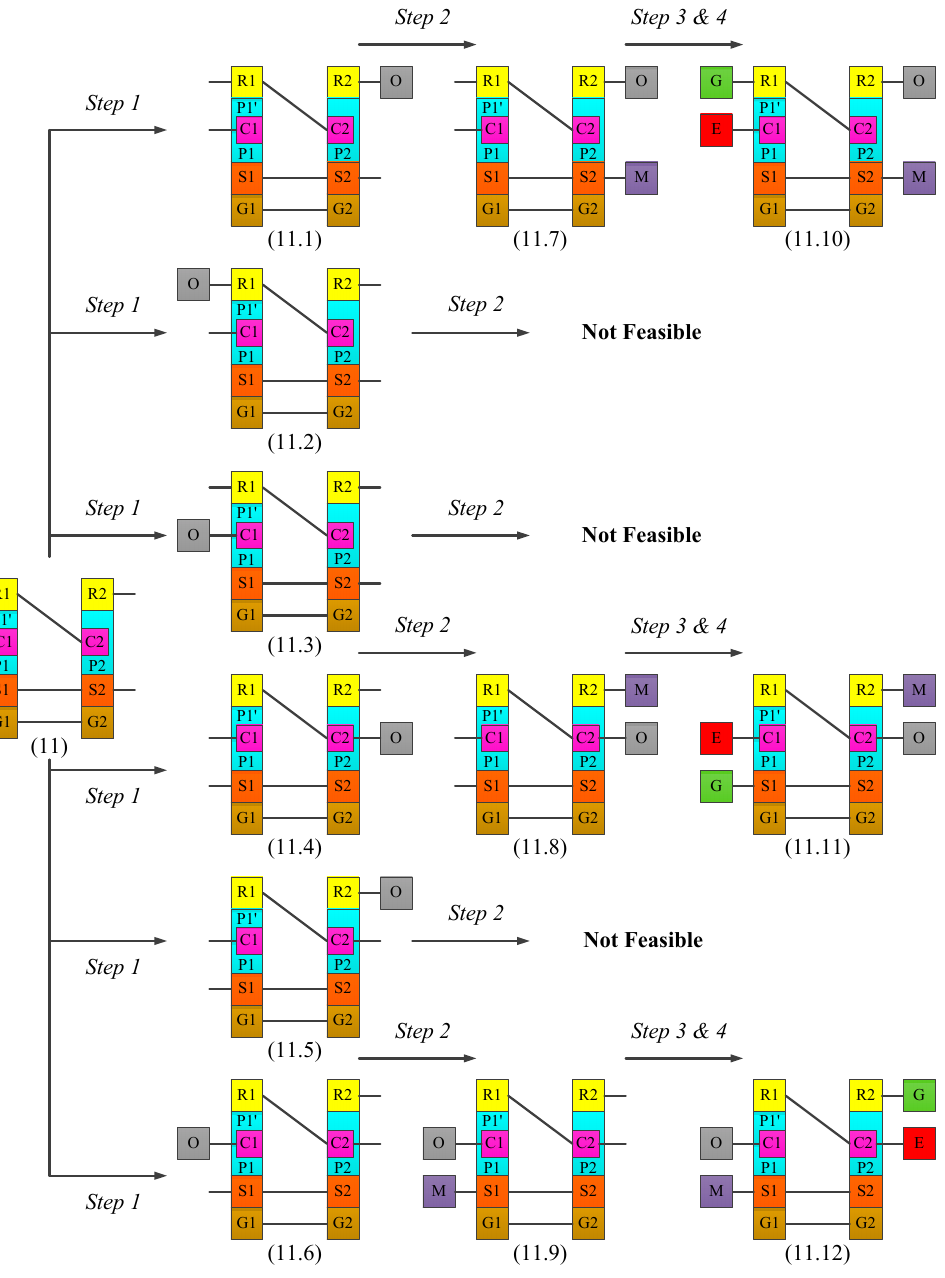
Figure 6. Process of power arrangement. E: engine; M: motor; G: generator; O: output shaft.